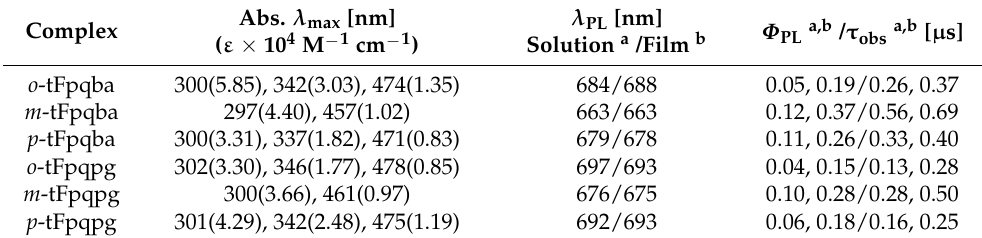
Table 1. Photophysical data of all new complexes.